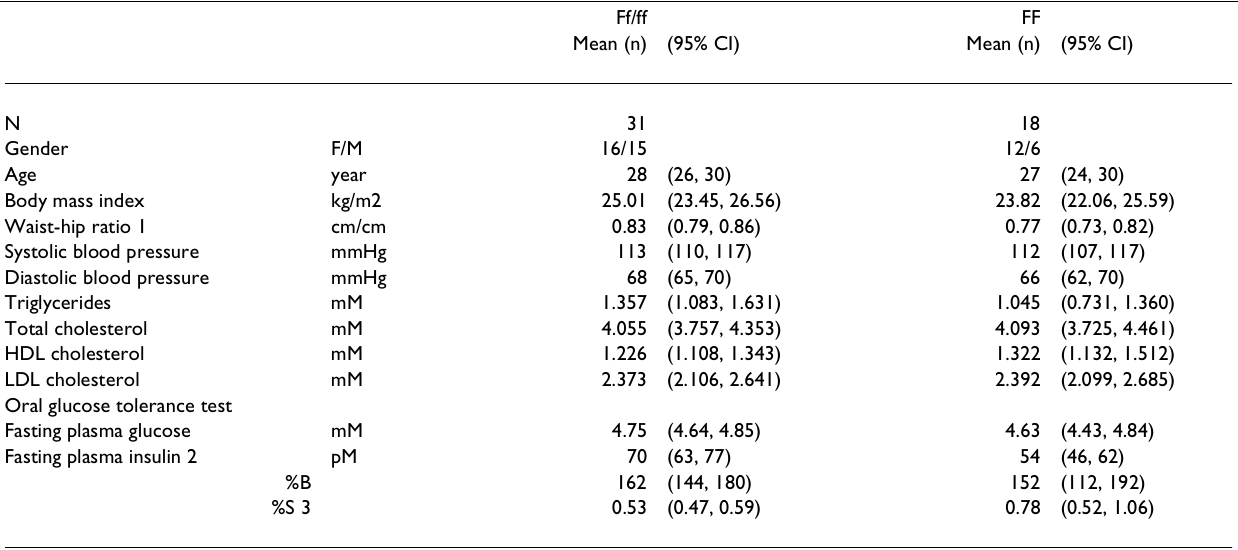
Table 1: Clinical features and glycemic parameters by the VDR